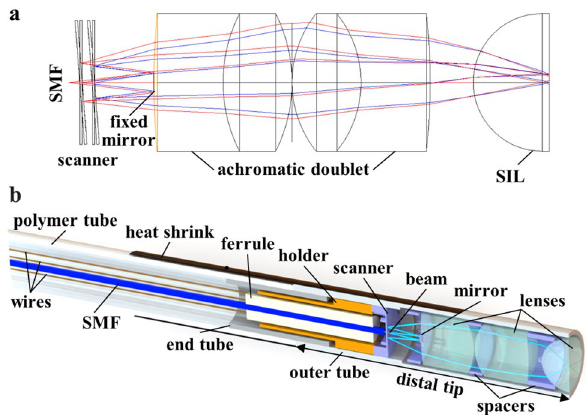
Figure 5. Folded optical path and endomicroscope packaging. ( a ) The excitation beam exits the SMF, and passes through the center aperture of the scanner. The beam expands and reflects off a fixed circular mirror back toward the scanner for lateral deflections. The focusing optics consists of a pair of achromatic doublets and a solid immersion (half-ball) lens that provides contact with the mucosal surface. ZEMAX 2013 (https:// www. zemax. com/) was used for the optical design and ray-trace simulation. ( b ) Packaging arrangement for the individual components of instrument, including single mode fiber (SMF), scanner, mirror, and lenses, is shown. Solidworks 2016 (https:// www. solid works. com/) was used for the 3D modeling of the endomicroscope